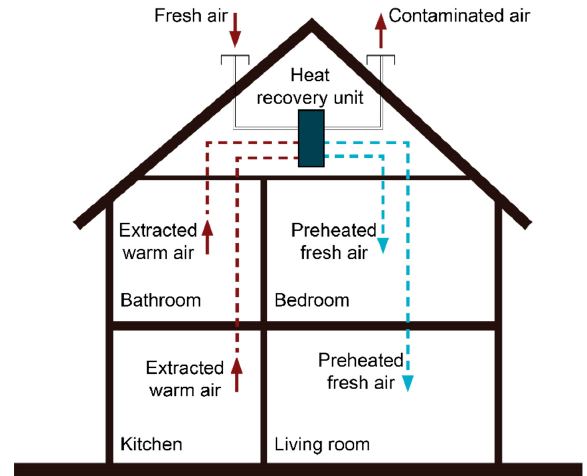
Figure 1. Typical heat recovery system for a residential building application [7].